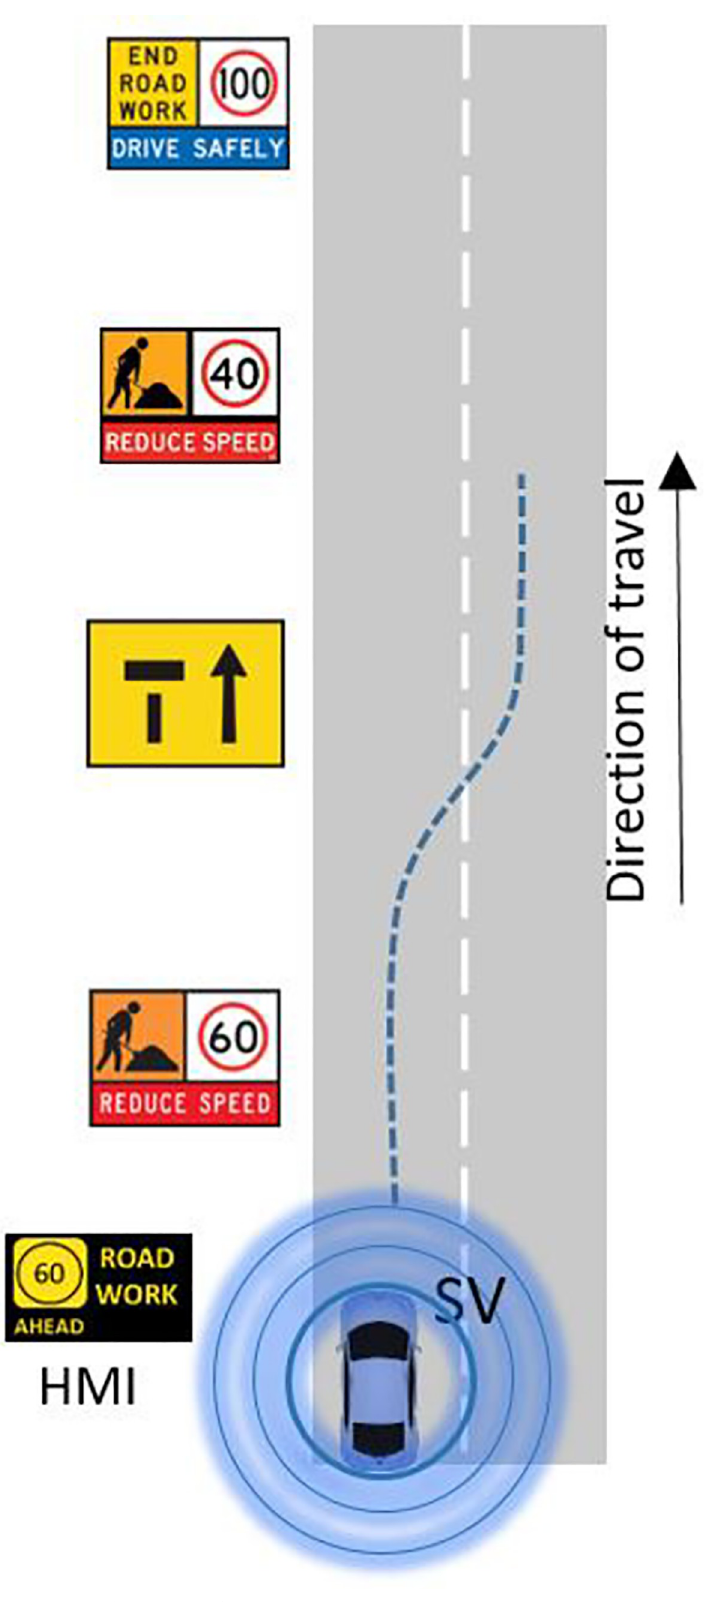
Fig 2. General operation of